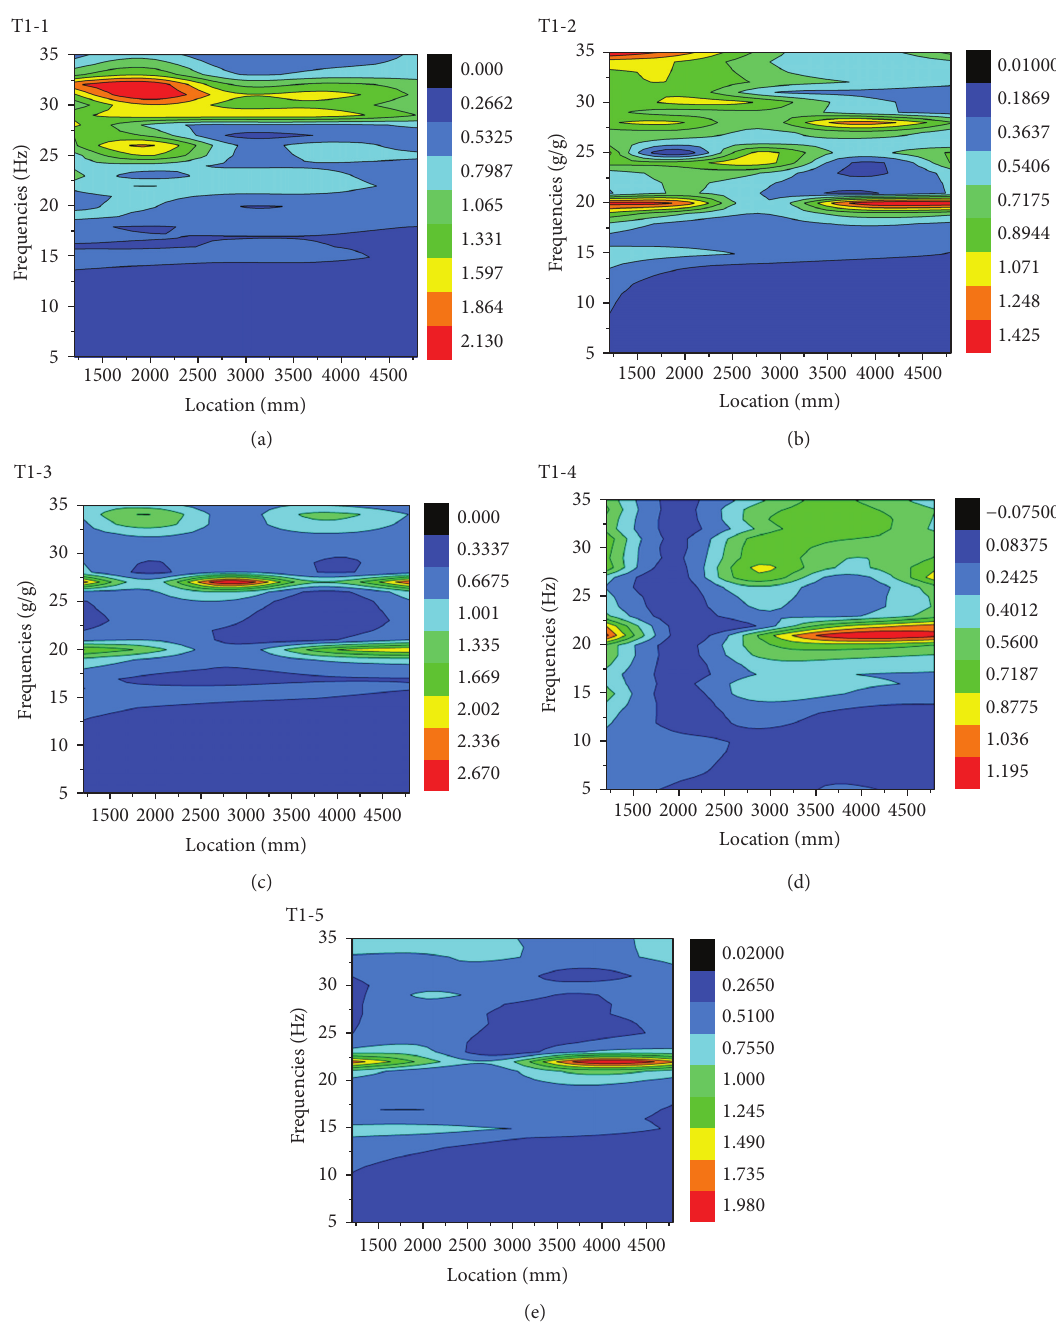
Figure 11: Transfer functions of the T1 test floors with the 400mm joist